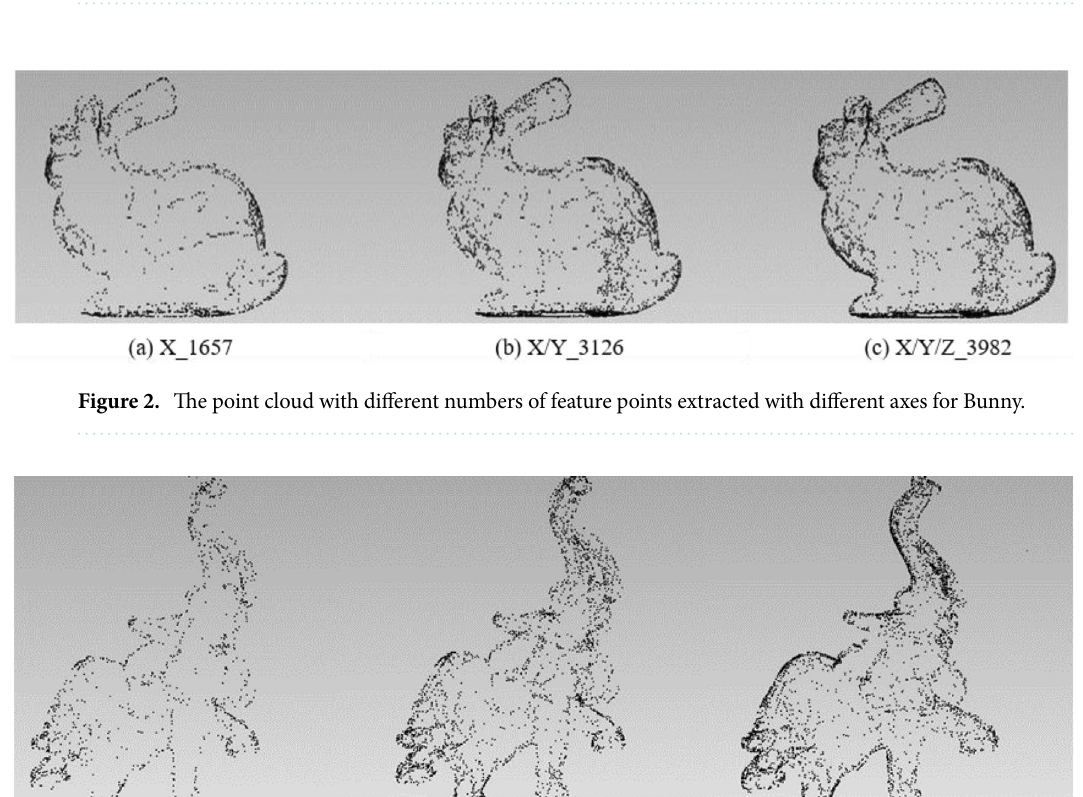
Table 1. Results of different feature points under X-axis, X/Y-axis, and X/Y/Z-axis with 60°.